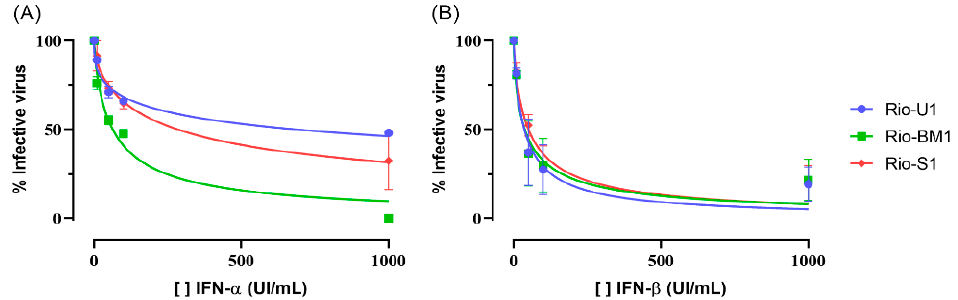
Figure 6. Effect of type I IFN treatment on ZIKV proliferation in Vero cells. The cells were infected at MOI 0.1 for 24 h, and the virus titer in the supernatant was determined by plaque assay. Viral titers under treatment with IFN α and IFN β were normalized with the values obtained from non- treated infected cells. The graphs represent values of normalized-viral yields obtained for each tested concentration of ( A ) IFN- α and ( B ) IFN- β . Data were analyzed with GraphPad Prism 8 software. The curves were fitted by nonlinear regression of normalized data with variable slope.